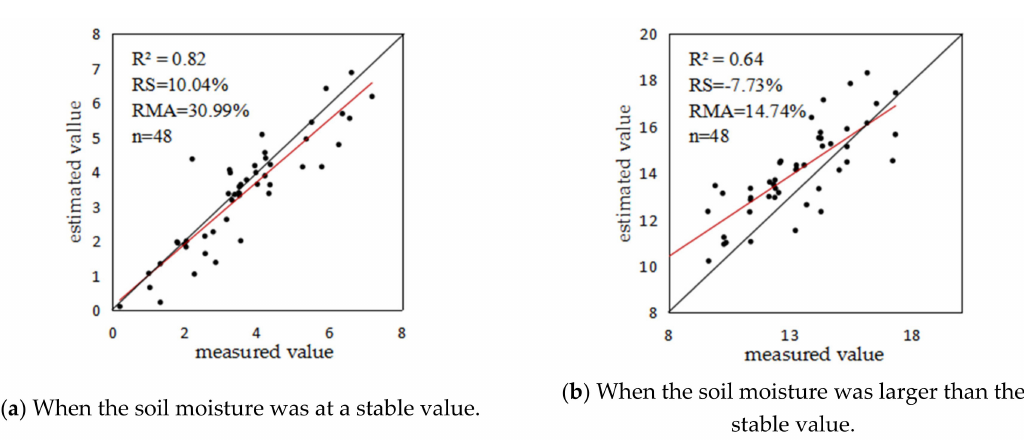
Figure 8. The comparison of the 0–10 cm soil moisture between the measured value and the estimated